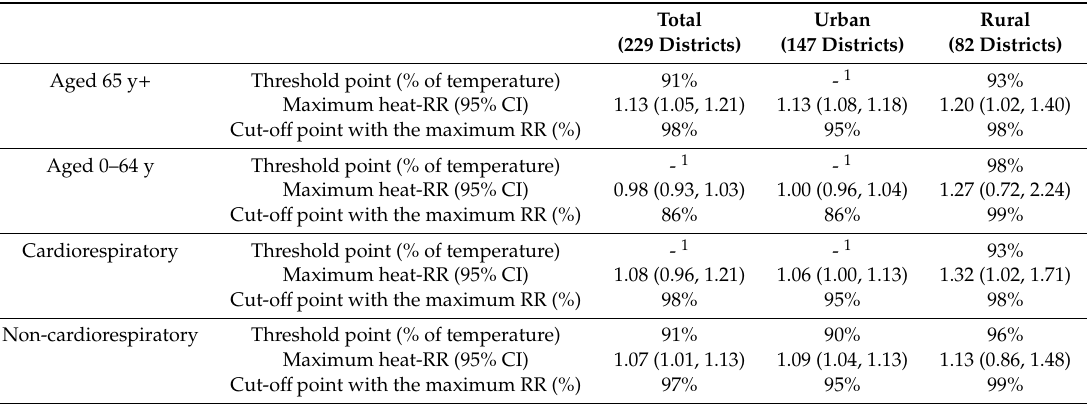
Table 3. Sub-population analysis results of the threshold point, cut-o ff point with the maximum RR, and the maximum value of pooled heatwave-related mortality risk (RR) by age and mortality cause group in the total, urban, and rural